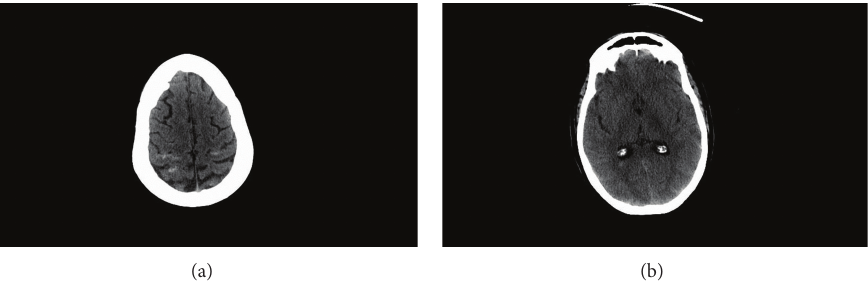
Figure 3: Axial CT head images without contrast on postoperative day 0 demonstrating subarachnoid hemorrhage bilaterally in the posterior frontoparietal regions (a) and hemorrhage in the occipital horn of the right lateral ventricle